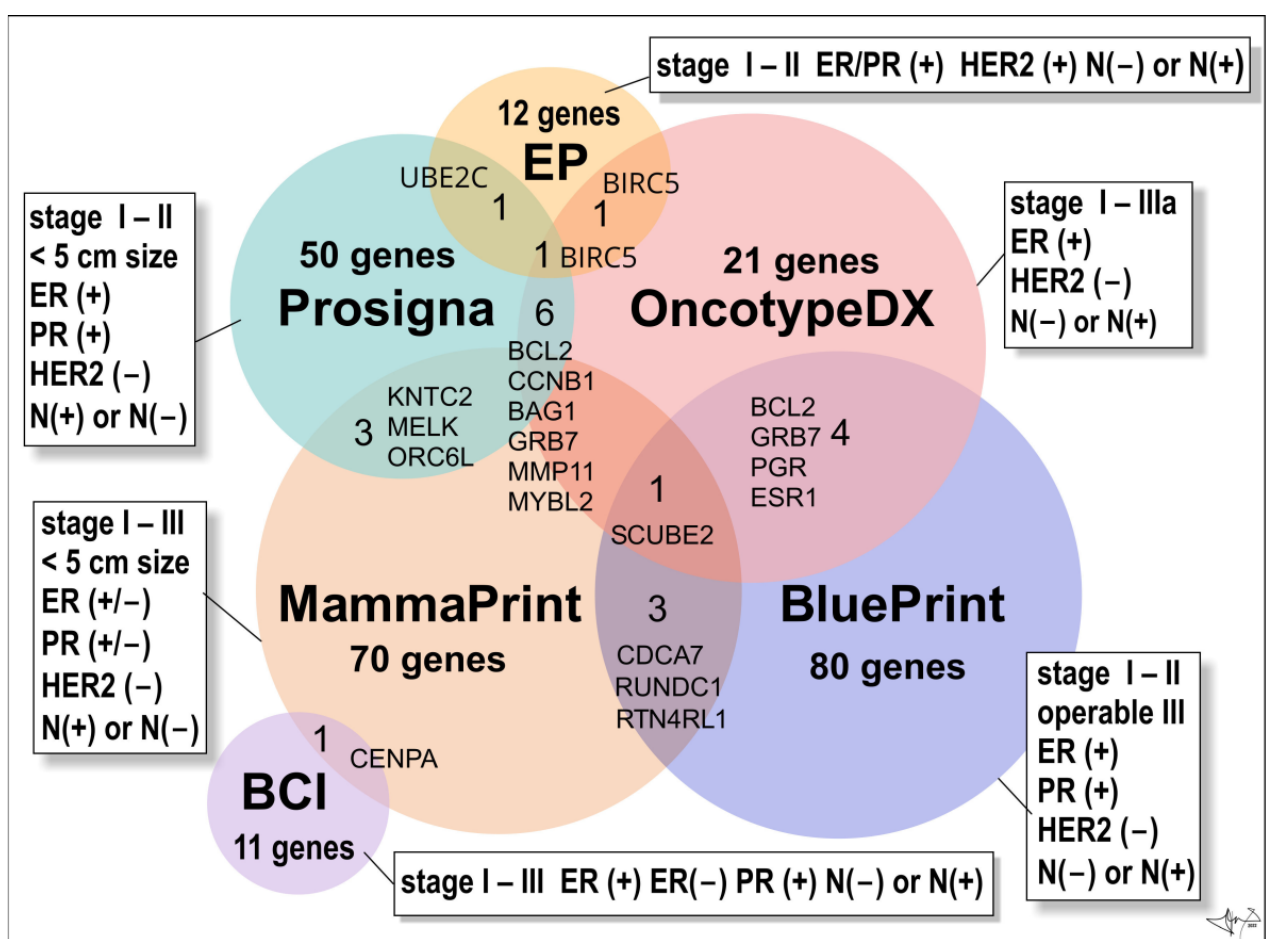
Figure 5. Multigene BC tests. Venn diagram is presenting numbers of genes/proteins evaluated by commercially available multigene tests. Abbreviations: ER(+) and ER( − ) oestrogen receptor positive or negative cancers, respectively; PR(+) and PR( − ), progesterone receptor positive or negative cancers; HER2(+) overexpression of HER2 oncoprotein; N( − ) not present in lymph nodes, N(+) present in 1 to 3 lymph nodes [21].